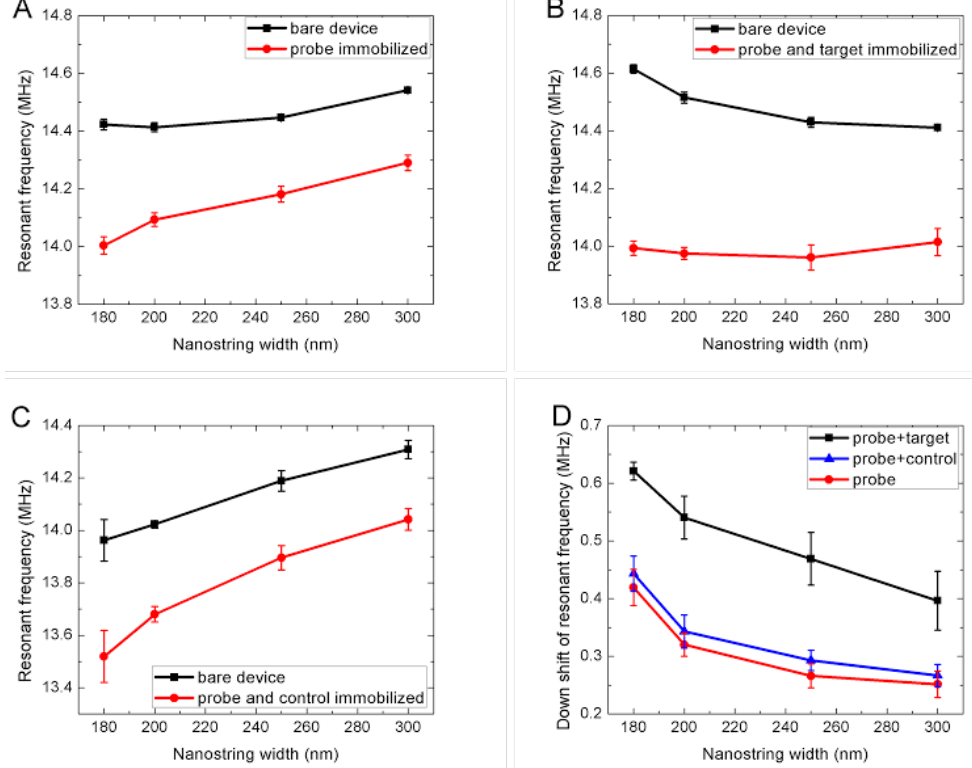
Figure 5. Resonant frequency change of nanostring resonators in samples A, B and C due to surface functionalization. Each of the chips has an array of 20 devices. The resonant frequency is obtained based on statistical analysis of five devices of the same string width. ( A ) Chip A: bare device versus the attachment of aryl film, anti-rabbit IgG and BSA. The black squares and red circles respectively designate the bare resonators and resonators immobilized with probe i.e. , anti-rabbit IgG and BSA; ( B ) Chip B: bare device versus the attachment of aryl film, anti-rabbit IgG, BSA and rabbit IgG. The black squares and red circles respectively designate the bare resonators and resonators immobilized with probe i.e. , anti-rabbit IgG and BSA and target rabbit IgG; ( C ) Chip C: bare device versus the attachment of aryl film, anti-rabbit IgG, BSA and goat IgG. The black squares and red circles respectively designate the bare resonators and resonators immobilized with probe i.e. , anti-rabbit IgG, BSA and control goat IgG; ( D ) Comparison of down shifts of resonant frequencies due to the surface adsorption of probe, probe and target, and probe and control. The red circles designate the resonators of chip A immobilized with probe i.e. , anti-rabbit IgG, BSA. The black squares correspond to the resonators of sample B immobilized with probe and target rabbit IgG. The blue triangles designate the resonators of sample C immobilized with probe and control goat IgG.